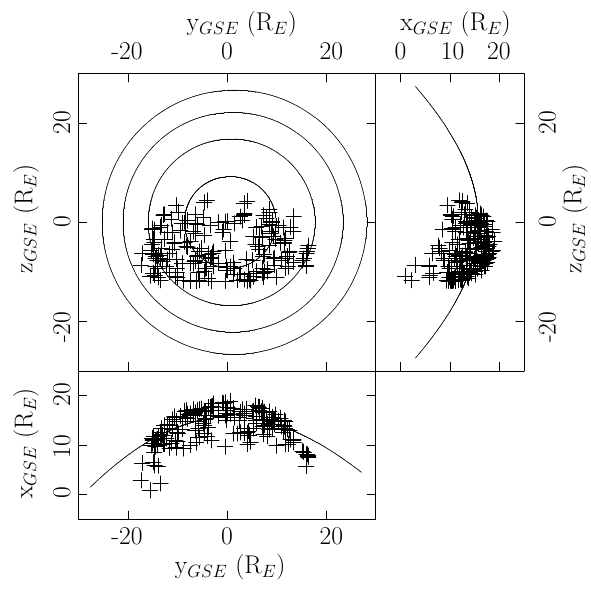
Fig. 2. Locations of the 204 foreshock cavities identified during the 2005 and 2006 Cluster dayside seasons. The left hand part shows the cavities projected onto the yz, xy, and xz GSE planes. Sections through model bow shock are also included; the concentric curves in the yz plane are sections taken through the model at the terminator and at 4, 8, and 12R E sunward of the Earth.